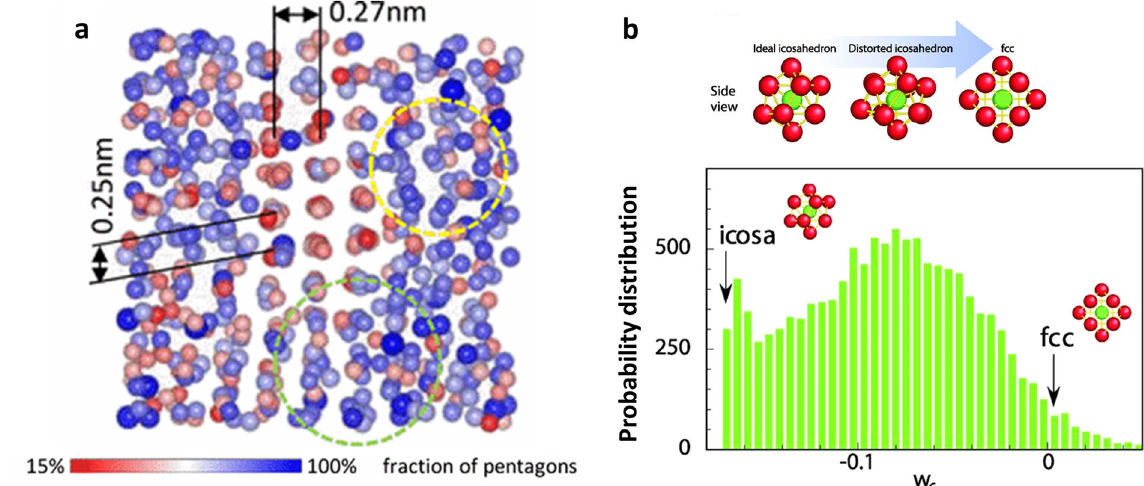
range structure preference from an embedded atom potential. 38 The atoms are colored by the fraction of pentagons in their Voronoi polyhedron. b Probability distribution of bond orientational order (w 6 ) in a 12,000-atom MD model, together with the characteristic w 6